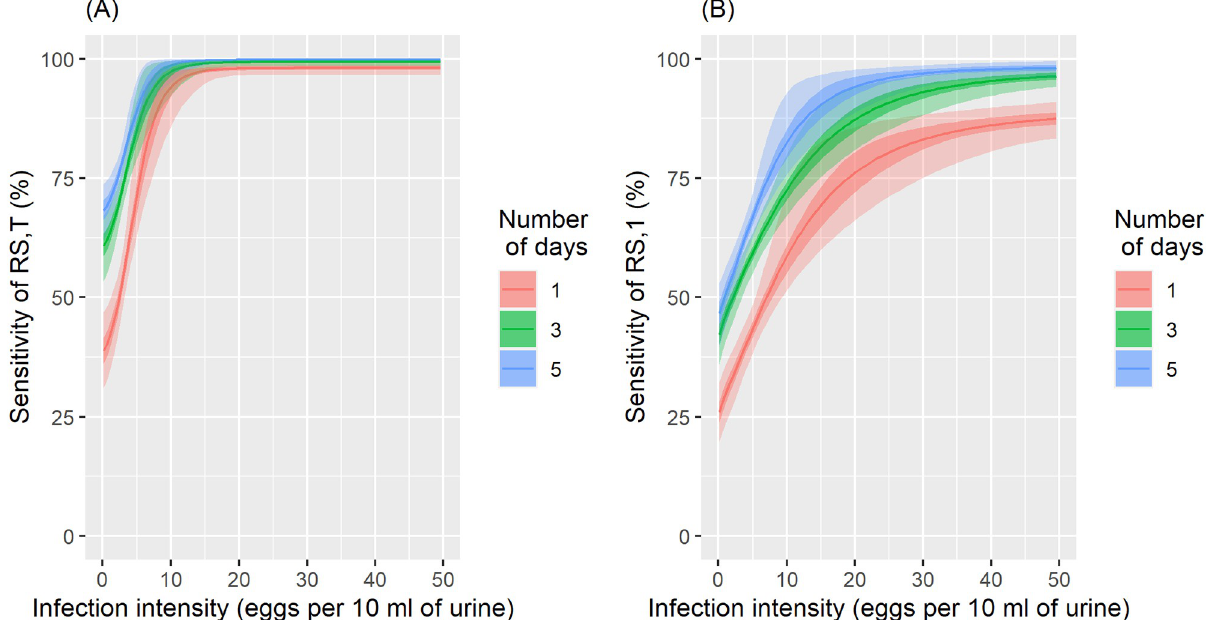
Fig 3. Sensitivity of a reagent strip (RS) in relation to infection intensity for measurements from a single to a total of 3 and 5 cumulative tests. Trace results were included in the positives (A) and trace results were included in the negatives (B). Dark shaded areas are the 50% and light shaded areas the 95% Bayesian credible interval.